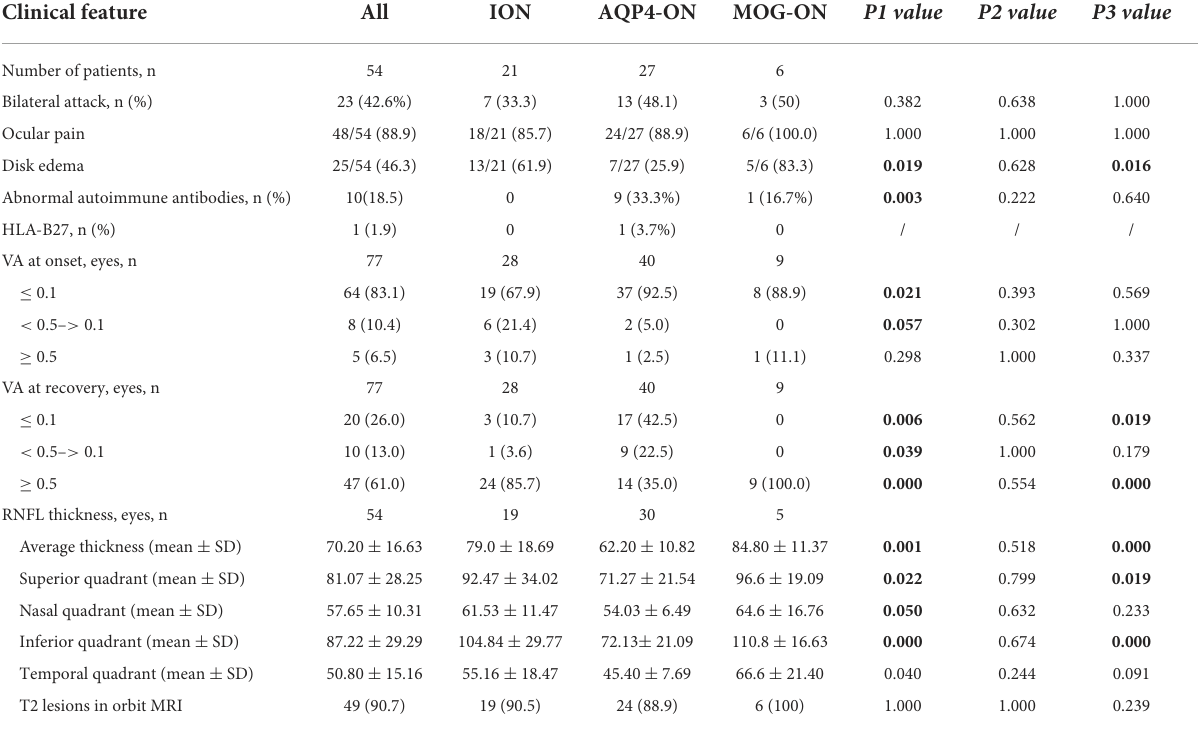
TABLE 2 The clinical features and prognosis of pregnancy-related ON in different